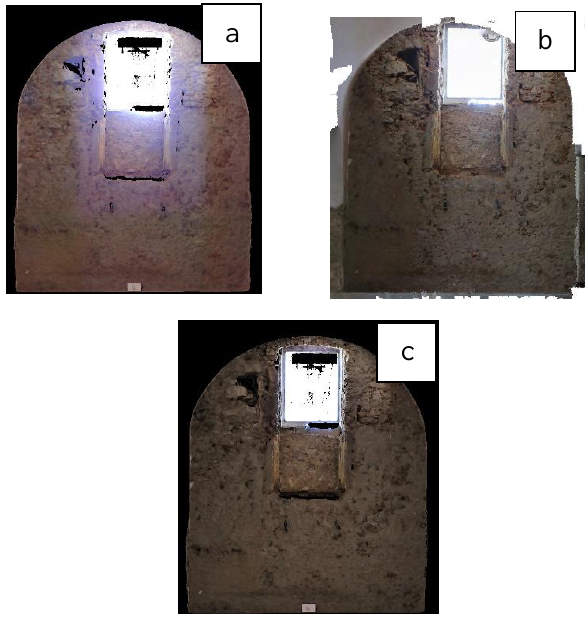
Figure 12 . TLS (a), CRP (b) and TLS+CRP (c)